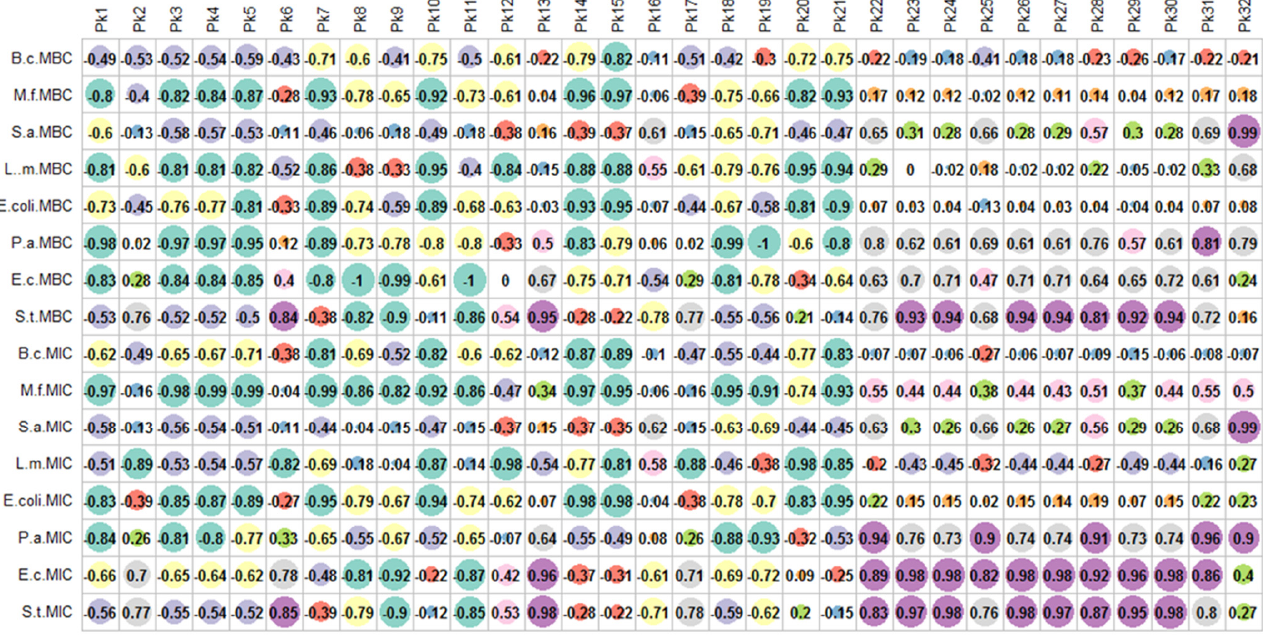
Figure 4. Relationship between phytochemical compounds and antibacterial activities.